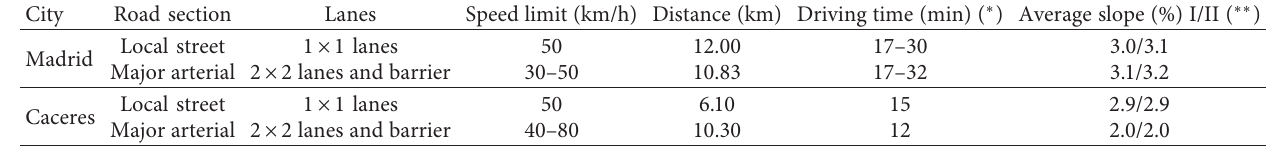
Figure 2: Location of the field trials in Caceres and Madrid, Table 1: Information on driving urban routes tested in both cities.